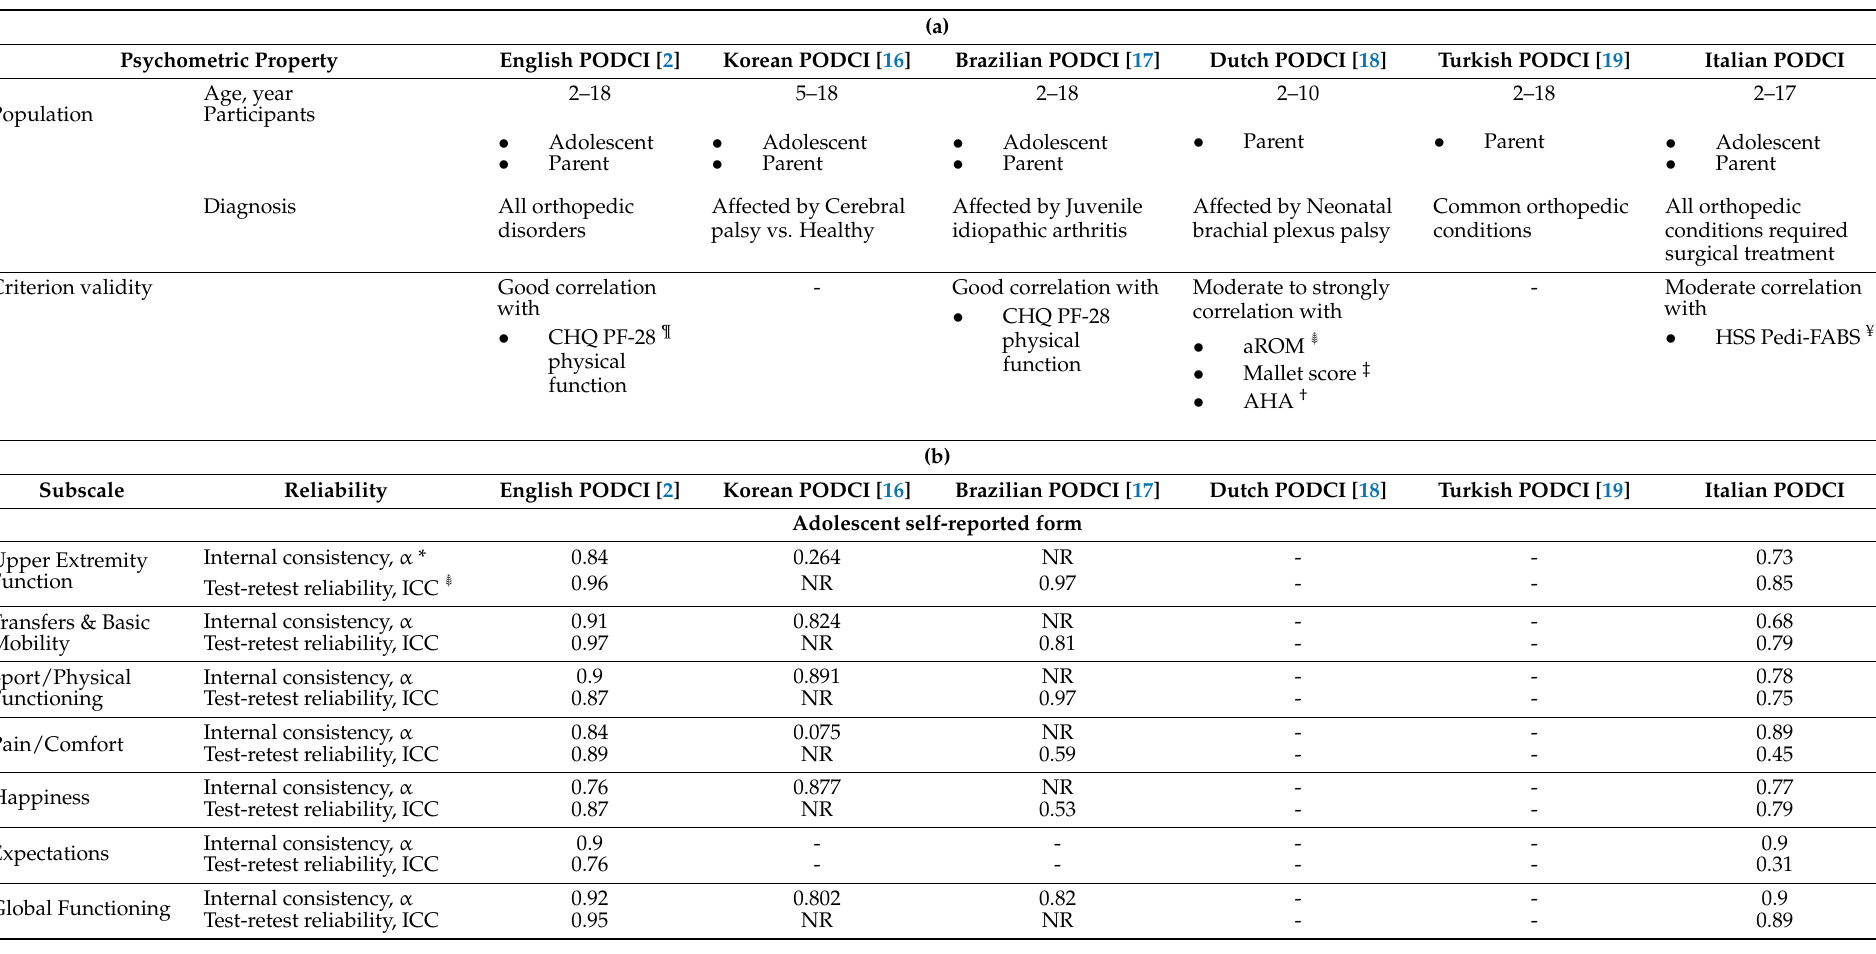
Table 5. ( a ) Comparison between the Original English, Korean, Brazilian, Dutch, Turkish, and Italian Pediatric Outcome Data Collection Instrument (PODCI) on population and criterion validity. ( b ) Subscales’ comparison between the Original English, Korean, Brazilian, Dutch, Turkish, and Italian Pediatric Outcome Data Collection Instrument (PODCI) on reliability. Table 1. Patient demographics and clinical characteristics.